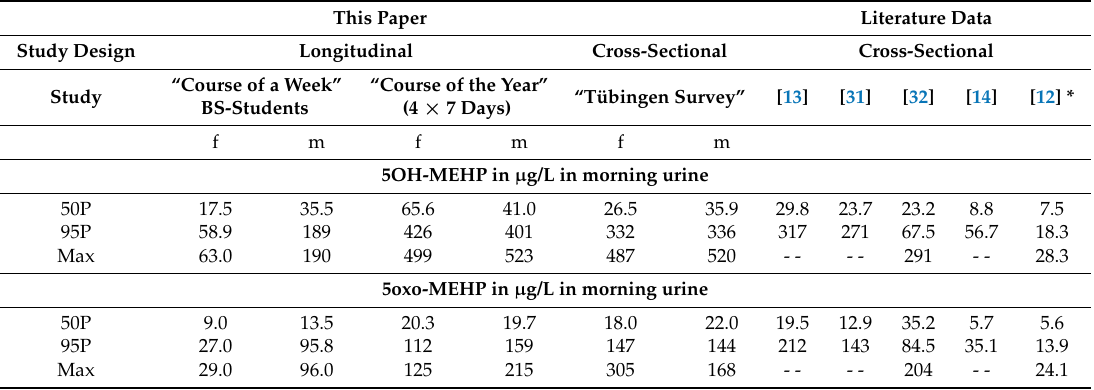
Figure 8. Mean and 50th percentile (median) of the sum of 5OH-MEHP + 5oxo-MEHP for female (f) and male (m) participants aged 15–30 years and ≥ 40 years for the “course of the years”-longitudinal study (4 × 7 d) and the “Tübingen Survey” cross-sectional study. Table 3. 5OH-MEHP, 5oxo-MEHP in morning urine for subjects aged 15 to 30 years. This paper results compared with published data from cross-sectional